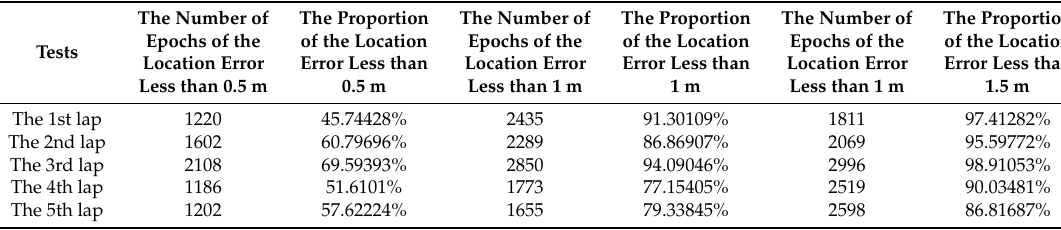
Table 2. Statistics of location error in the lateral direction of the lane.